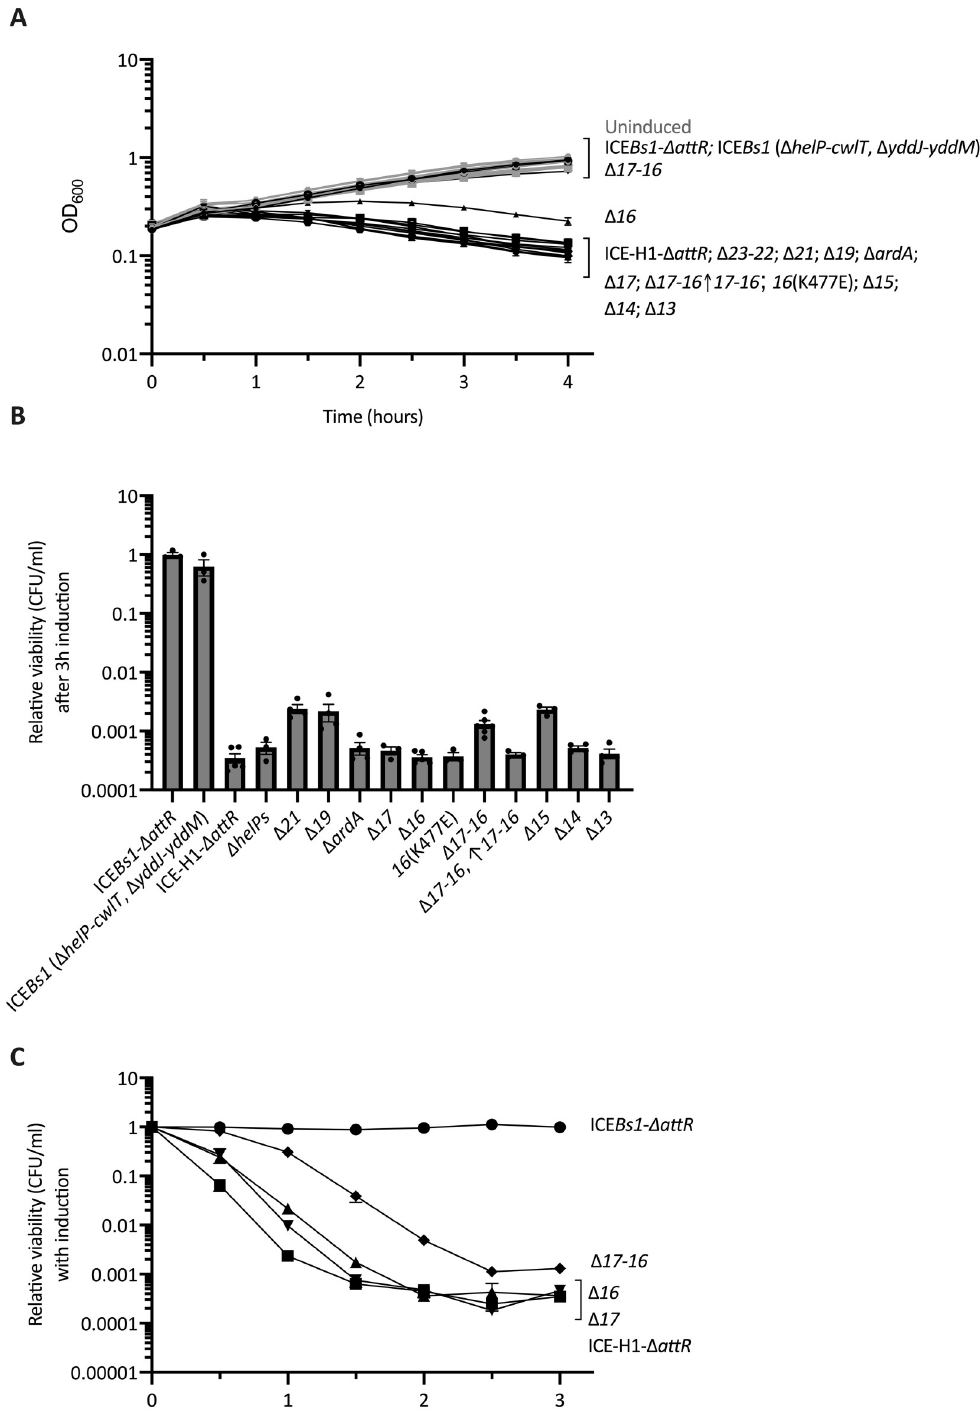
Fig 3. orf16 and orf17 are involved in the growth arrest caused by ICE-H1. Strains containing ICE Bs1 - Δ attR (Rep- due to Δ nicK ) (closed circles, ELC1095), ICE Bs1 ( Δ helP - cwlT , Δ yddJ - yddM ) (open circles, ELC1226), or ICE-H1- Δ attR (Rep- due to Δ orf20 ) (closed squares, ELC1076) with the indicated deletion(s) are indicated in the figure. Deletions are indicated by gene name or number and include: Δ orf23 - 22 (open squares, ELC1945), Δ orf21 (closed hexagons, ELC1916), Δ orf19 (open hexagons, ELC1915), Δ ardA (stars, ELC1707), Δ orf17 (closed downward triangle, ELC1419), Δ orf16 (closed upward